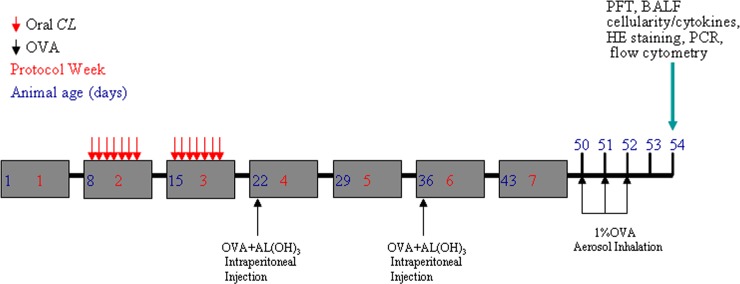
Schematic of a mouse model of early-life C. leptum ± OVA asthma.All analyses were carried out 48 h after the final protocol day. HE, hematoxylin–eosin; AL(OH)3, aluminum hydroxide.